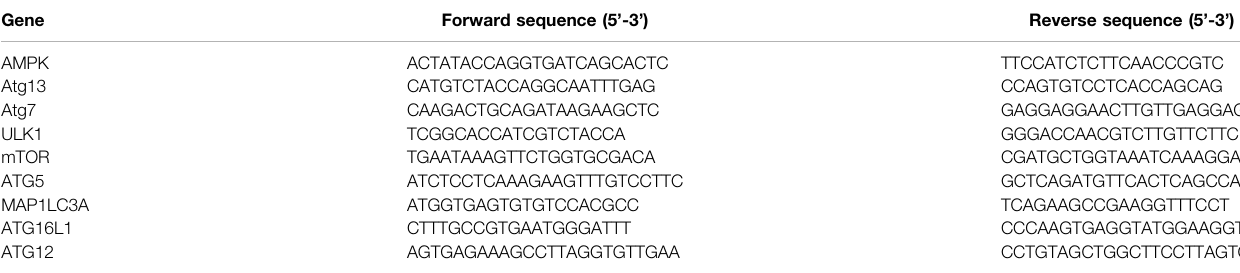
TABLE 2 | Primers for qPCR of gens used in this study.